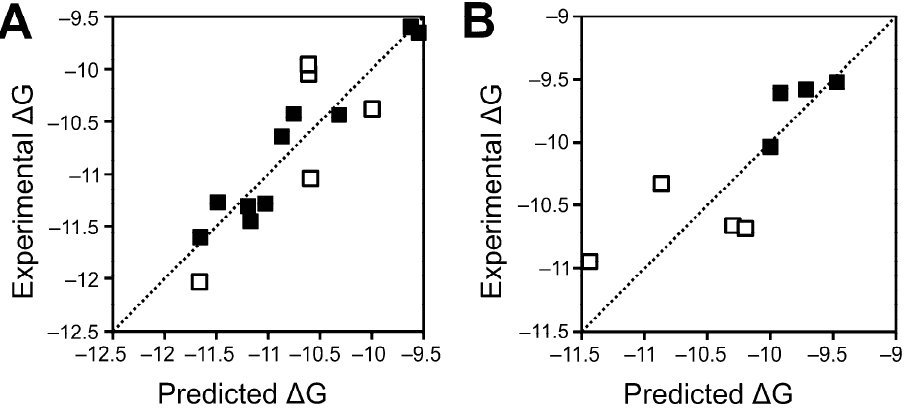
Table 2. Comparison of predictions made by Model 1 with experimental data for the training and test sets.